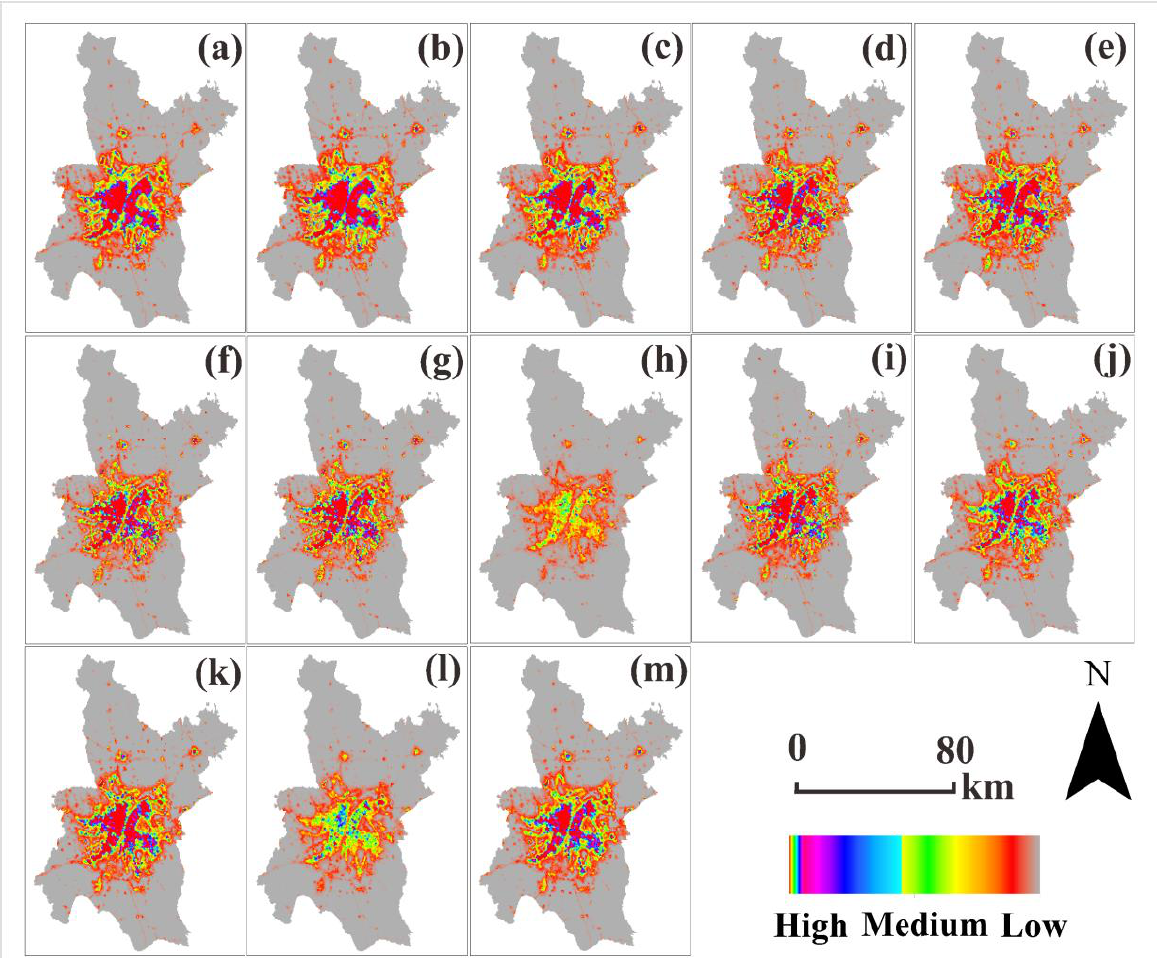
Figure 5. Monthly VIIRS images and annual stable images for Wuhan in 2013: ( a ) annual stable VIIRS data; ( b – m ) monthly images from January to December.